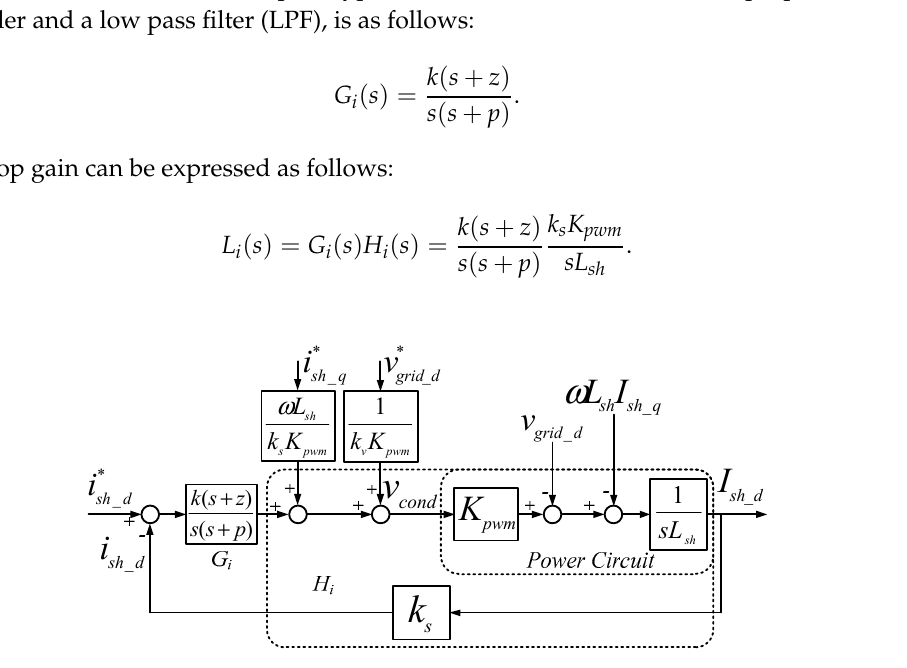
Figure 2. Block diagram of d-axis current controller.